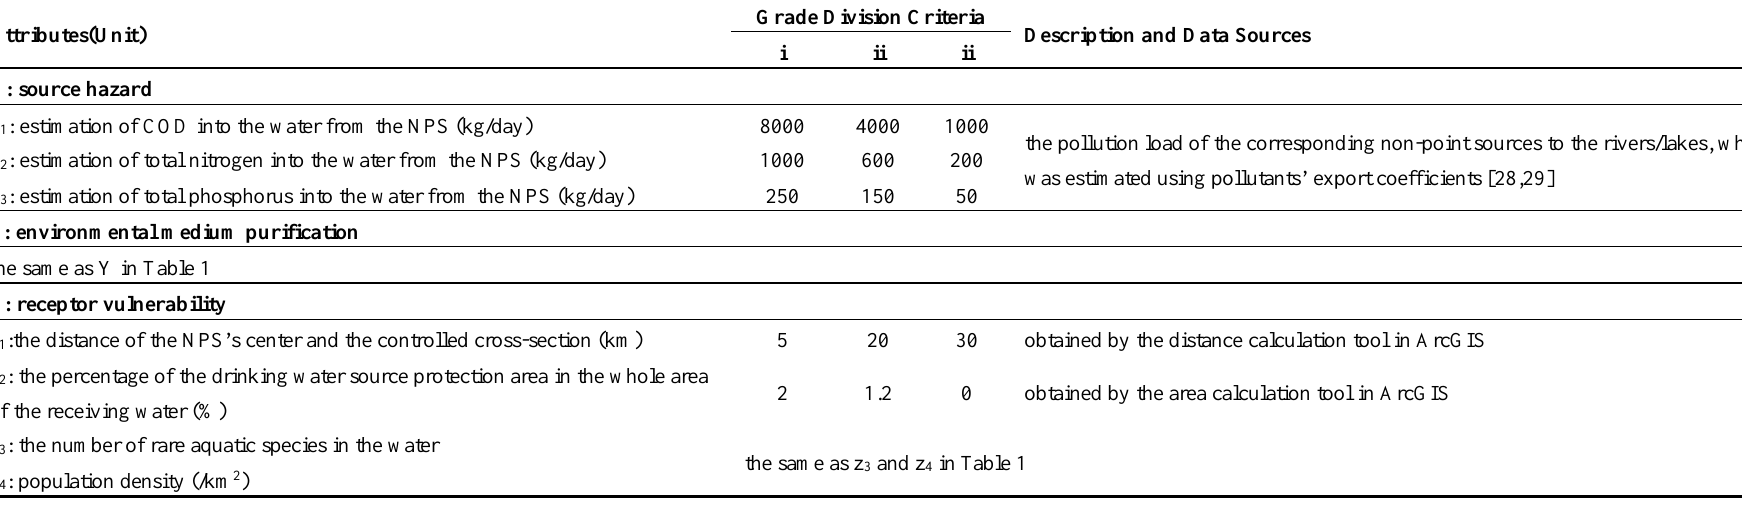
Table 2. Attributes of risk levels of NPSs and their grade division criteria.